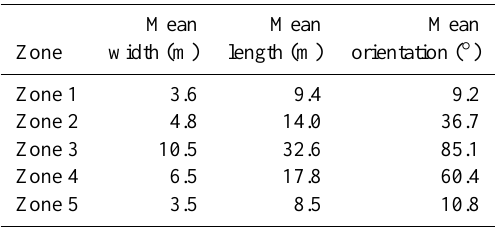
Table 2. Attributes of mean crevasse width, length and orientation in each zone labelled in Fig. 5. Orientations are measured along the long axis of each crevasse with respect to the direction of flow which is 0 ◦